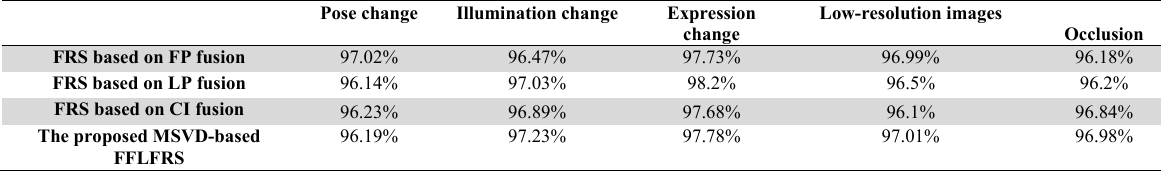
Classification accuracies of the proposed FFLFRS and the three FRSs under varying